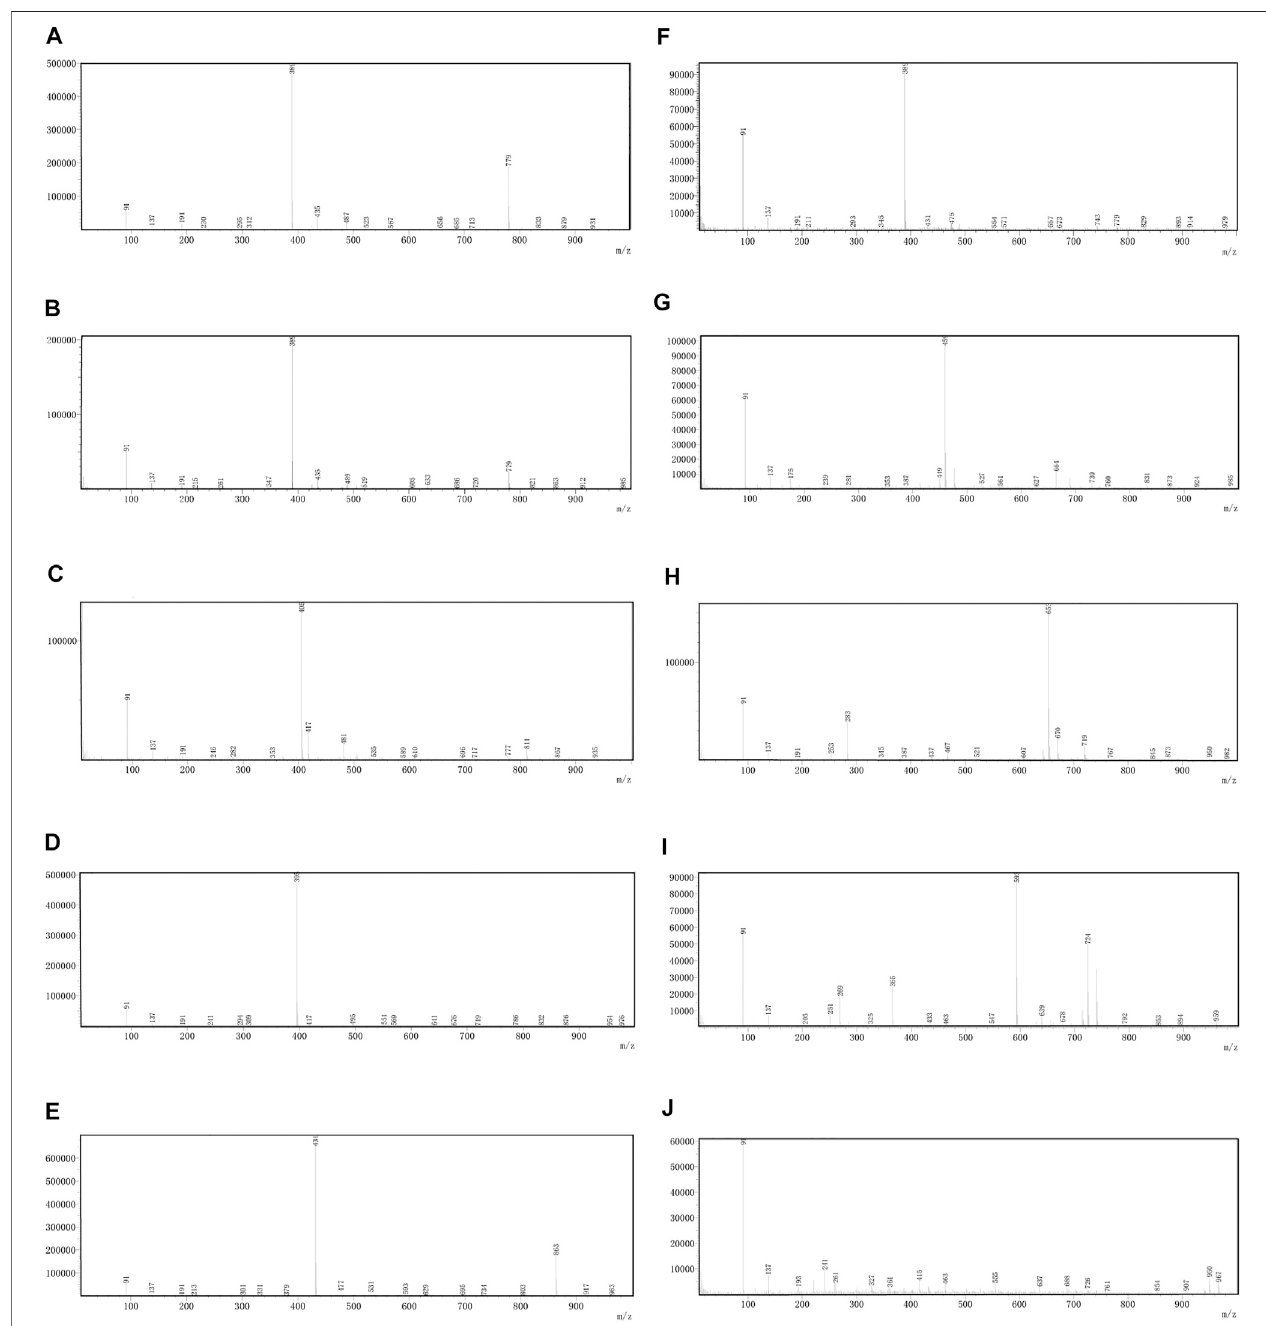
FIGURE 2 | Parent ion spectrums of the main ingredients. (A) Monotropein. (B) Deacetylasperulosidic acid. (C) 6,7-dihydroxy-7-(hydroxymethyl)-1- (((2S,3R,4S,5S,6R)-3,4,5-trihydroxy-6-(hydroxymethyl)tetrahydro-2H-pyran-2-yl)oxy)-1,4a,7,7a-tetrahydrocyclopenta [c]pyran-4-carboxylic acid. (D) 3-hydroxy-4- (((2S,3R,4S,5S,6R)-3,4,5-trihydroxy-6-((sulfooxy)methyl)tetrahydro-2H-pyran-2-yl)oxy)benzoic acid. (E) Asperulosidic acid. (F) Scandoside. (G) Asperuloside. (H) Hedanthroside C. (I) Hedanthroside B. (J) Ferulic